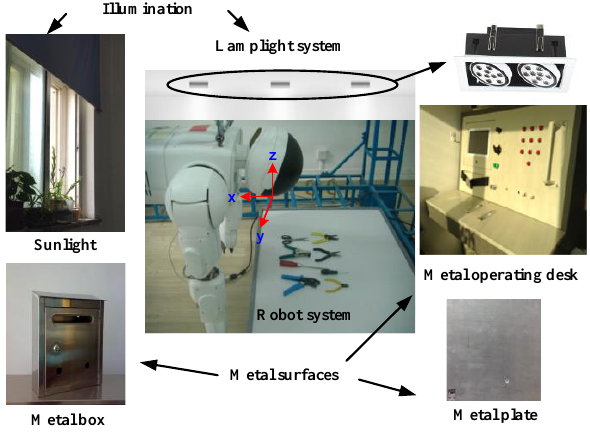
Figure 5. Lighting simulation system.